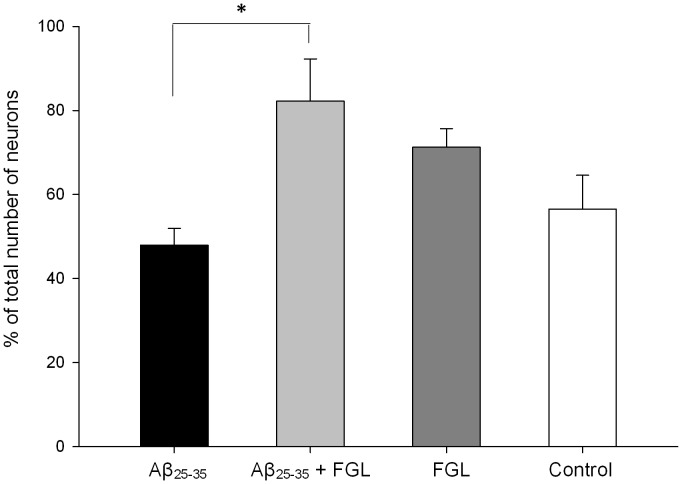
Percentage of CA1 pyramidal cells in the right dorsal hippocampus containing inactive GSK3β.Double immunocytochemistry and the optical fractionator method were used to establish the pyramidal cell density in the CA1 and also the density of pyramidal cells containing inactive GSK3β. The absolute numbers of both densities were calculated and the percentage of all the CA1 pyramidal cells that contained inactive GSK3β was established. The data was analysed using a one-way ANOVA and Tukey’s post-hoc test. Aβ25–35+FGL rats had a significantly higher percentage of pyramidal neurons in the CA1 that contained inactive GSK3β compared with Aβ25–35 alone rats. (*P<0.05). Mean ± SEM, n = 4.